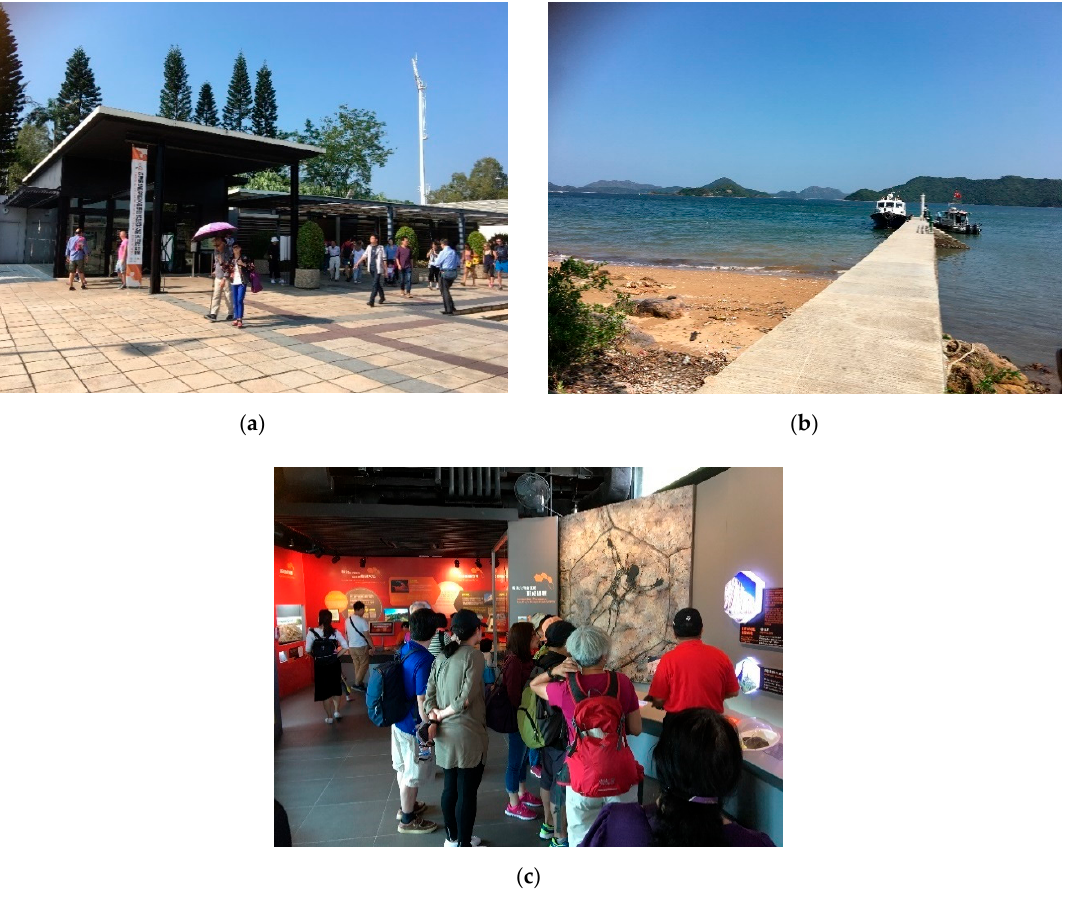
Figure 16. ( a ) Visitor center close to a boat pier in Hong Kong UGGp. ( b ) Geopark boat trip from a pier, including a visit to Lai Chi Wo. ( c ) Geopark visitor center.